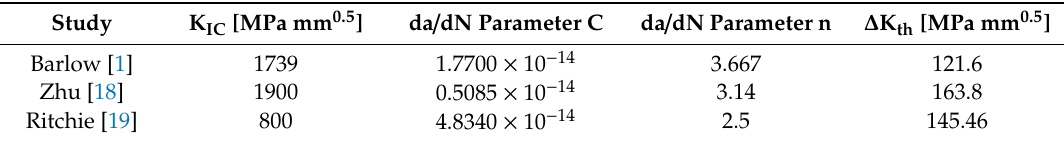
Table 5. Crack propagation parameters data for Ti-6Al-4V reported in different literature. Paris Coefficient (C) units *are compatible with (da/dN) in mm/cycle.